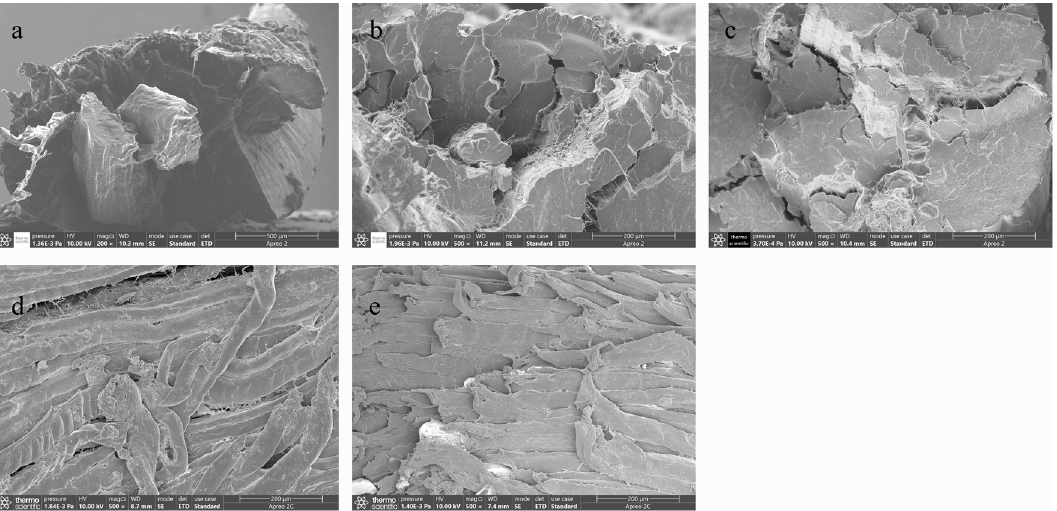
Figure 10. Changes in the beef tissue structure during storage with different low-temperature stor- age methods. ( a ) fresh beef; ( b ) refrigeration storage for 6 d; ( c ) ice temperature for 12 d; ( d ) micro- frozen for 18 d; ( e ) frozen for 18 d.